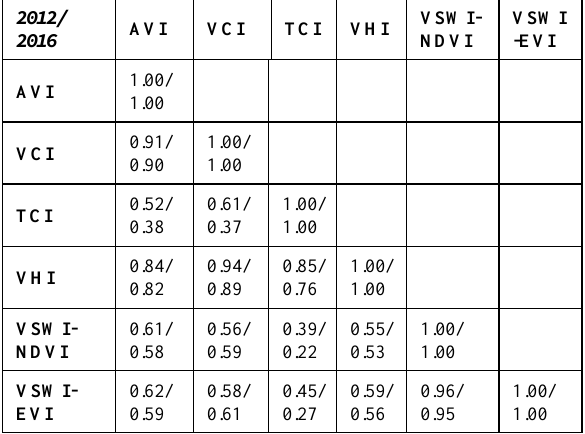
Table 2. Correlation matrix of typical remote sensing drought indices in a drought year (2012) and a normal year (2016) The results of correlation analysis show that the typical remote sensing drought indices from broad groups do not agree with each other. Among them, the index related to the surface temperature (i.e., TCI) has a poor consistency with other indices except for VHI which has no independence in the correlation analysis. Similar situation occurs in two versions of VSWI (i.e., VSWI- NDVI, VSWI-EVI).